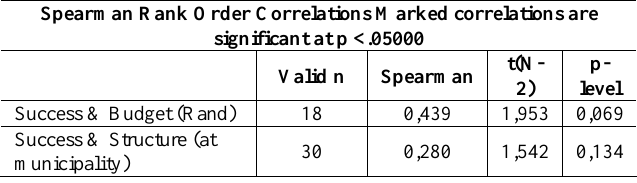
Table 8: Methodology and alliance success